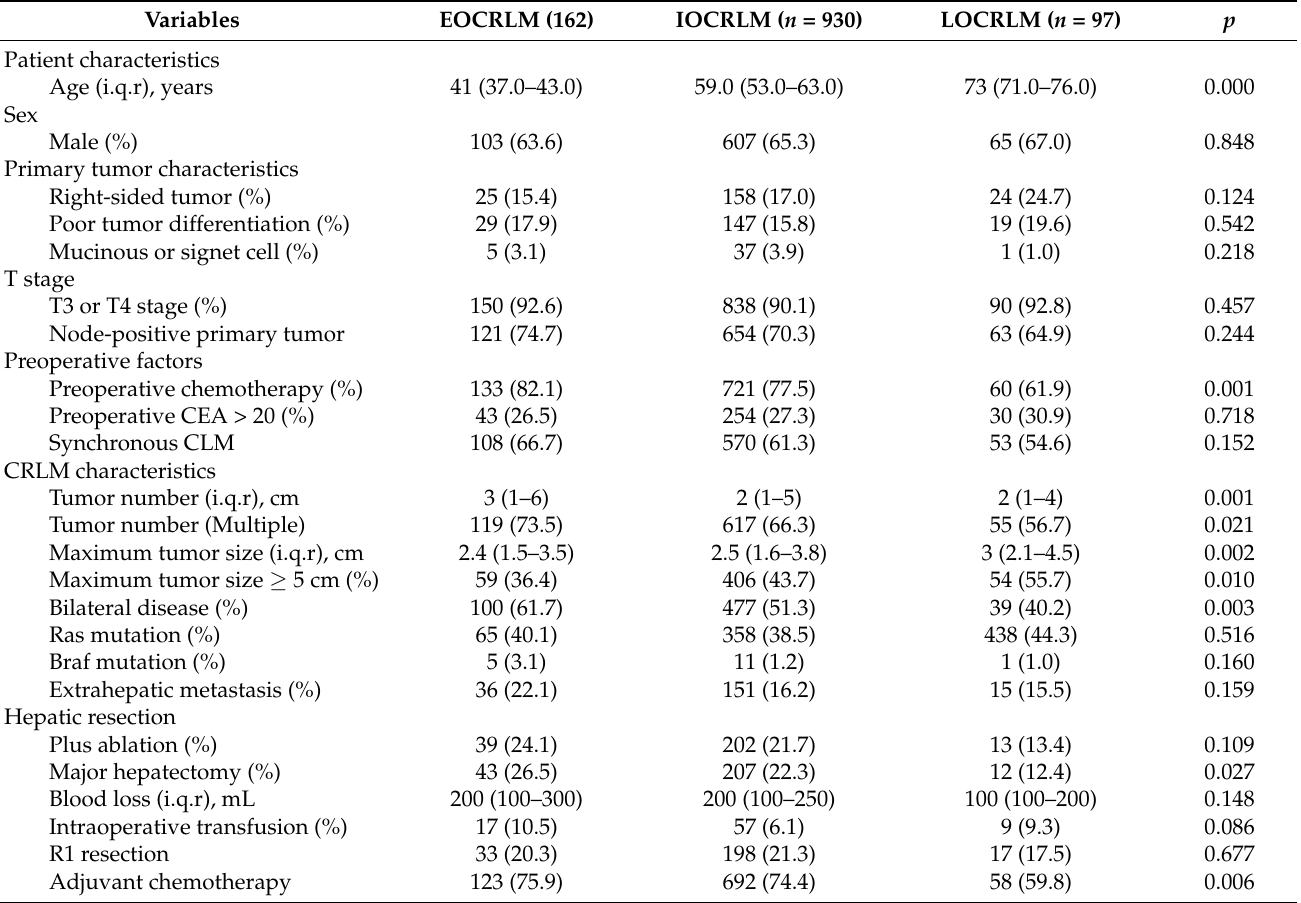
Table 1. Patient characteristics according to age group before